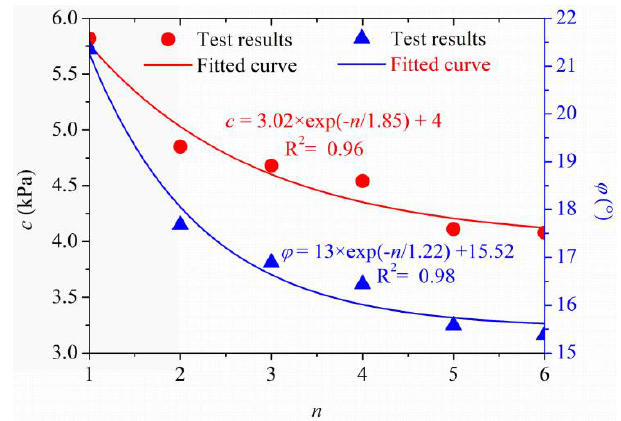
Figure 3. Relationships between cohesion and angle of shearing resistance with dry-wet cycles. Note: c = cohesion, ϕ = angle of shearing resistance, n = numbers of dry-wet cycles.